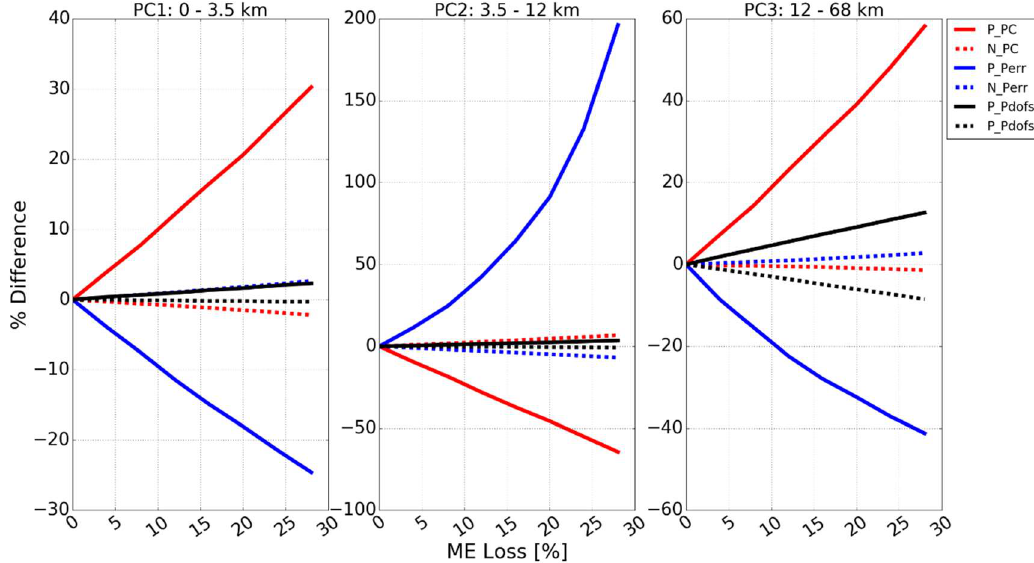
Figure 3. The same as Figure 2 but for CO.